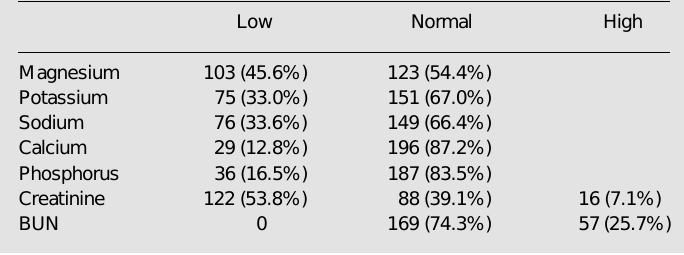
Table 3 - Univariate analysis comparing patients with low and normal serum magnesium levels according to the different clinical variables studied (chi- square